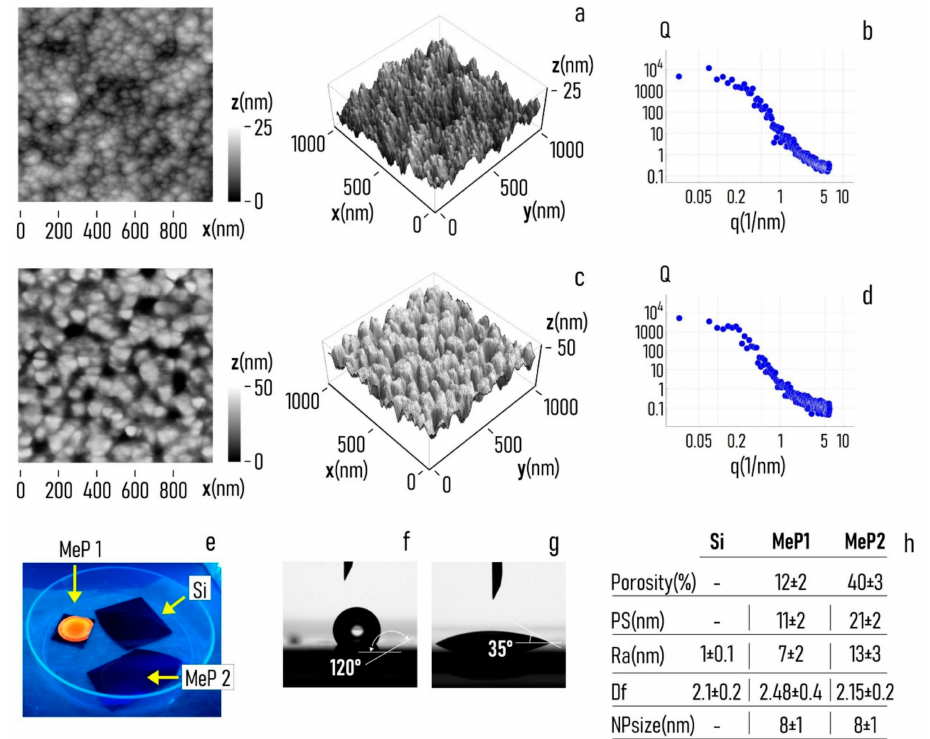
Figure 3. ( a ) Atomic force microscopy (AFM) profile of MeP 1 substrates functionalized with gold nanoparticles imaged over a sampling area of 1 × 1 µ m, the height values of the profile fall